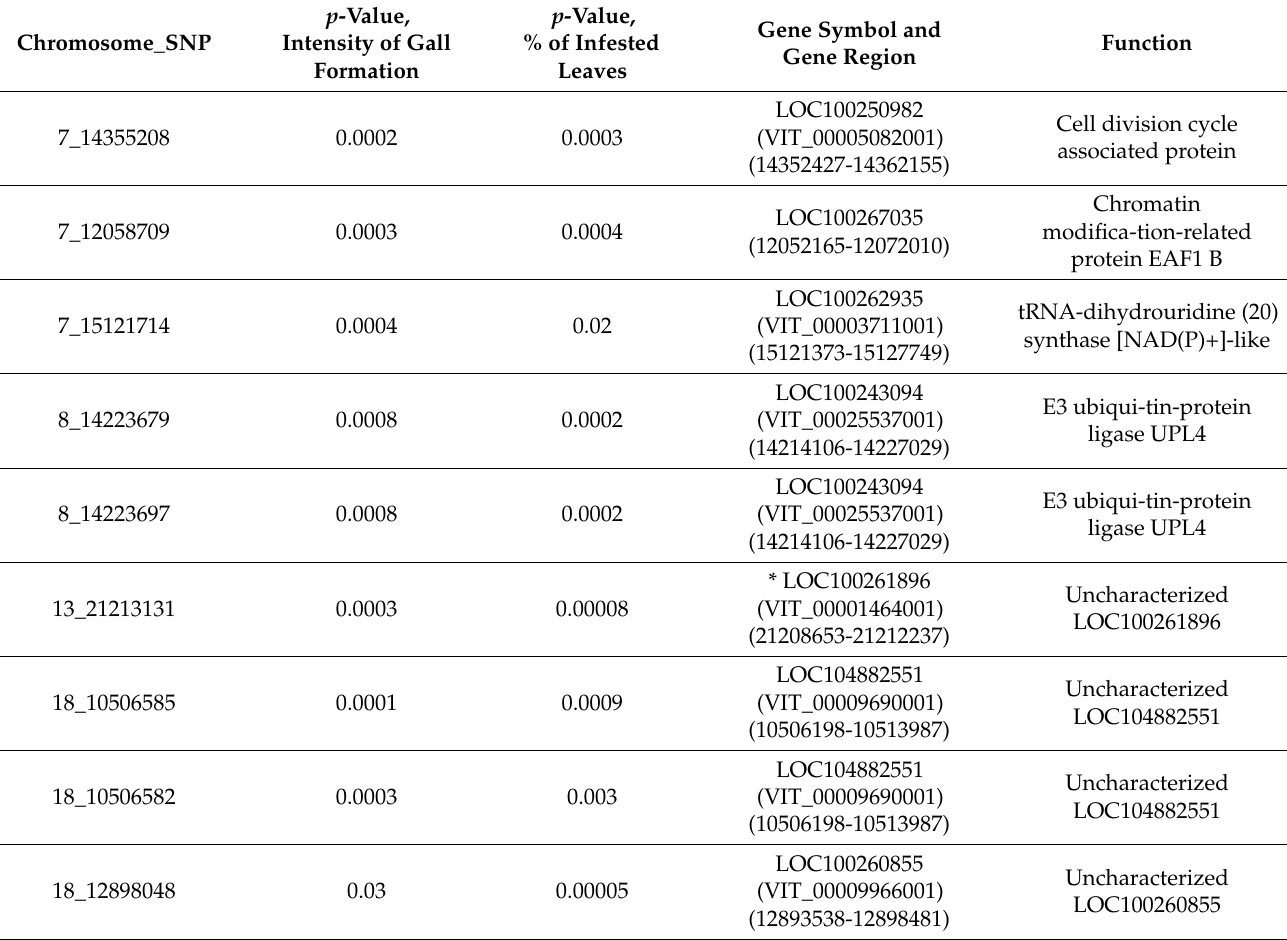
Table 3. SNPs polymorphic in three hybrid grape populations and associated with the traits ‘the percentage of infested leaves (P, %) and ‘intensity of phylloxera gall formation’ (R, %) according to GWAS